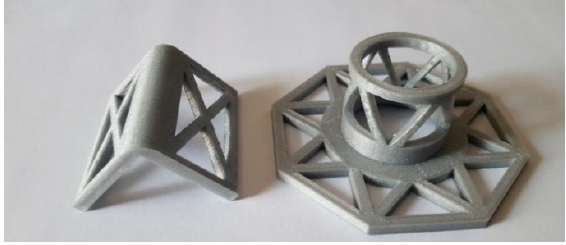
Figure 16. 3D printed rounded angle ( on the left ) and funnel-shaped plate ( on the right ) [1].